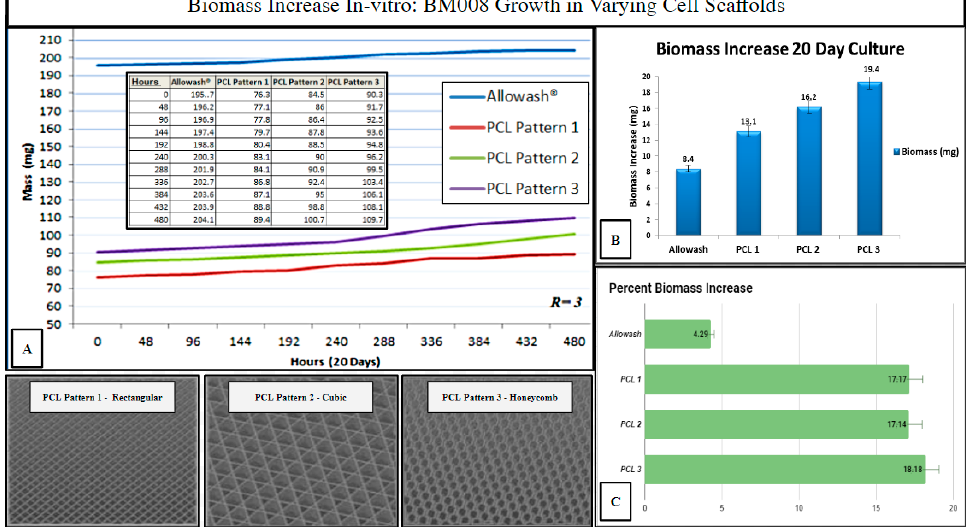
Figure 7. Biomass increase in varying infill pattern 3D printed PCL-scaffolds ( n = 3 each) as compared to Allowash ® cancellous bone cubes ( n = 3). Panel ( A ) shows the averages of total seeded scaffold mass (mg) measured over the study period at 48-hour intervals. Panel ( B ) displays each test group’s average biomass increase (mg). Panel ( C ) displays the average % biomass increase in each test group. The PCL Pattern-3 (Honeycomb) was selected for further studies based on this infill pattern’s superior % biomass increase.